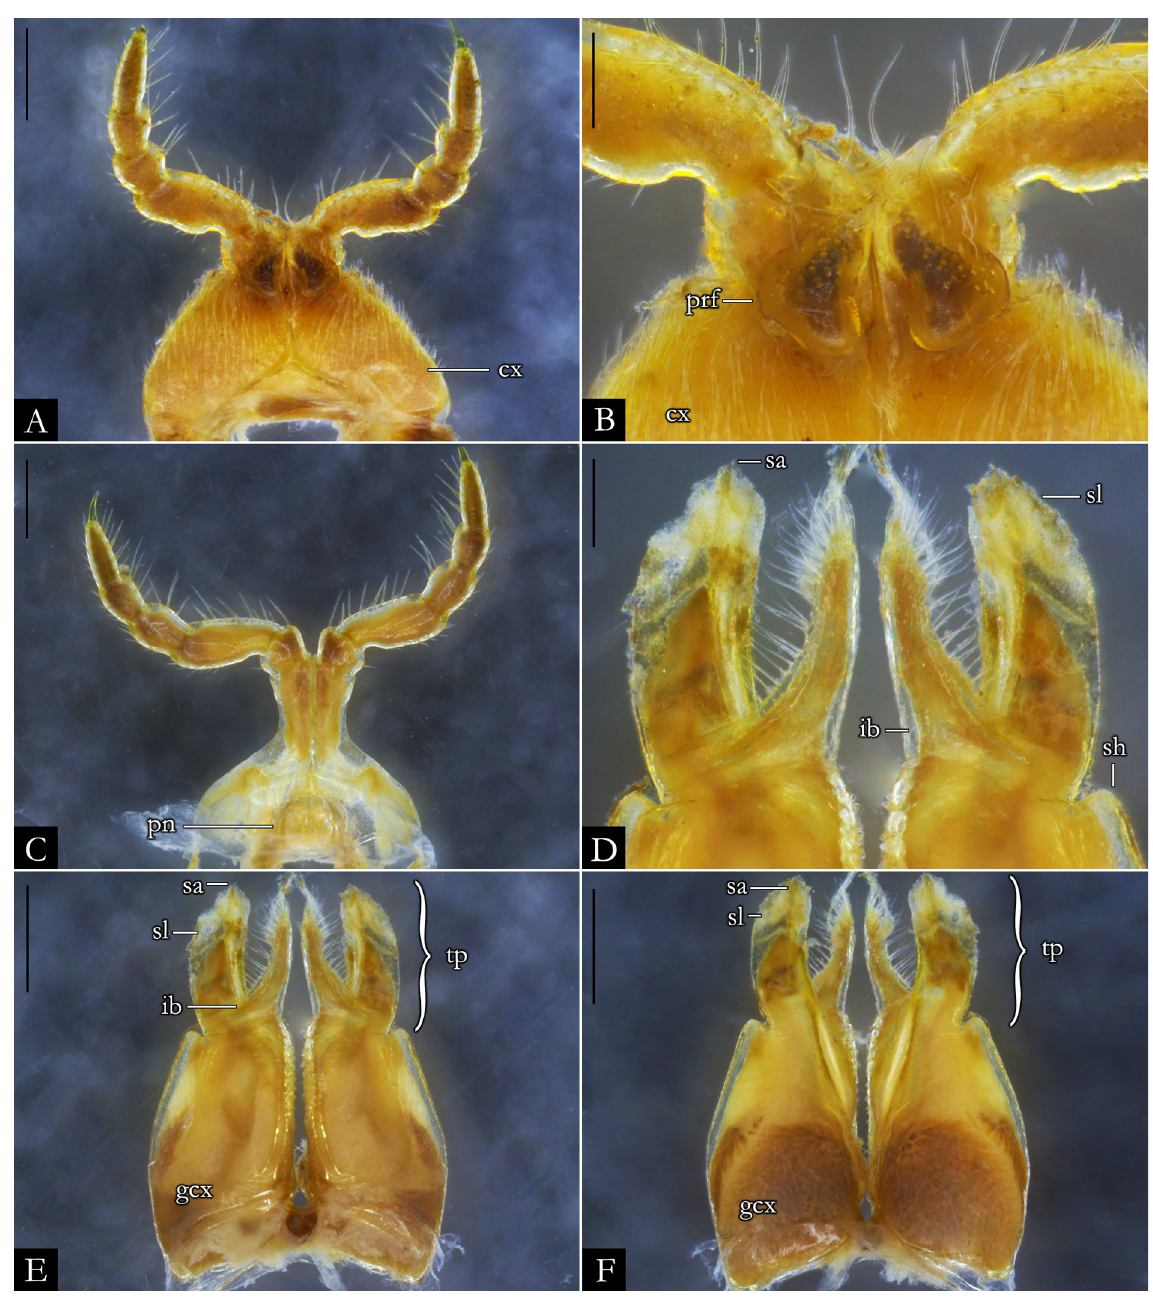
Fig. 67. Pseudonannolene erikae Iniesta & Ferreira, 2014, ♂ (IBSP 3331). A . First leg-pair. B . Detail of prefemur. C . Second leg-pair. D . Detail of telopodites, in anal view. E . Gonopods, in anal view. F . Gonopods, in oral view. Abbreviations: see Material and methods. Scale bars: A, E–F = 0.5 mm; B–D = 0.2